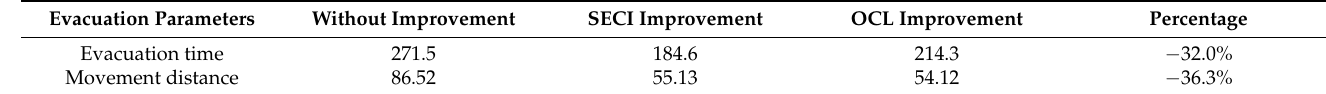
Table 8. Side-by-side comparison with suggested improvements.